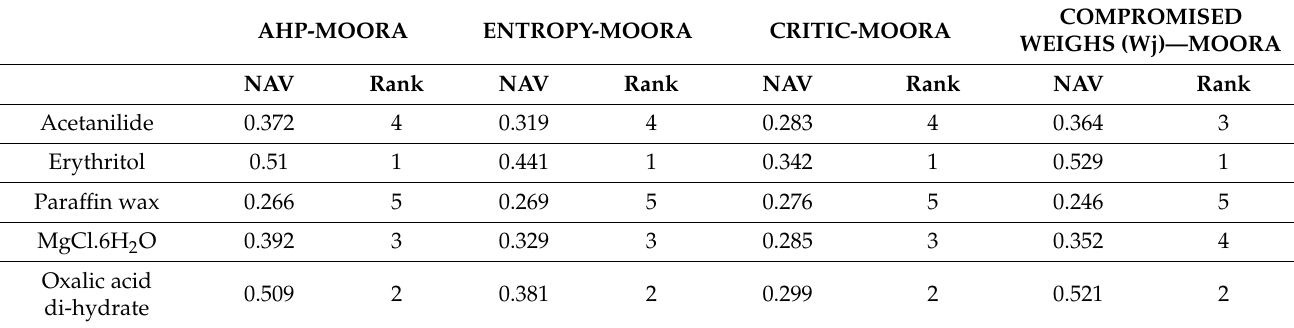
Table 3. Ranking of PCMs using the MOORA method with different criteria